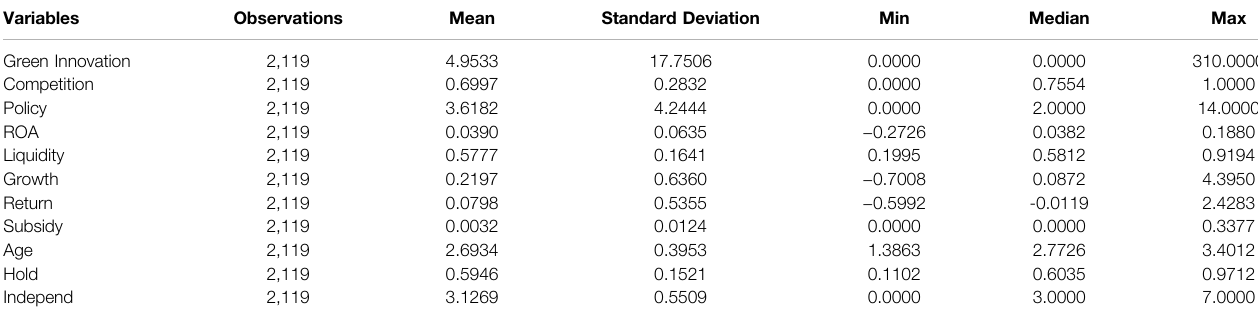
TABLE 2 | The results of descriptive statistics.